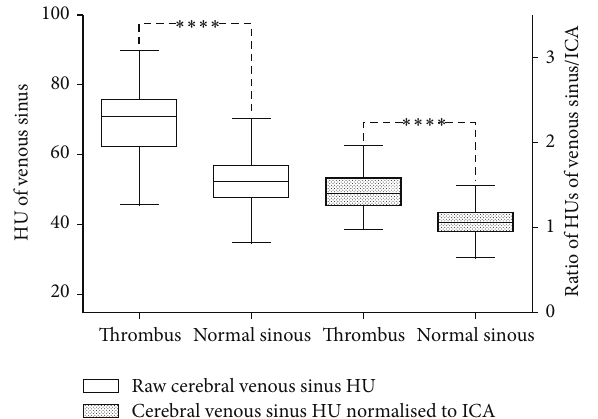
Figure 2: Comparison of cerebral venous sinus HU before and after standardisation to the ICAs in patients with and without CVST. ∗ ∗ ∗∗ = 𝑝 < 0.0001 two-tailed Student’s t -test.